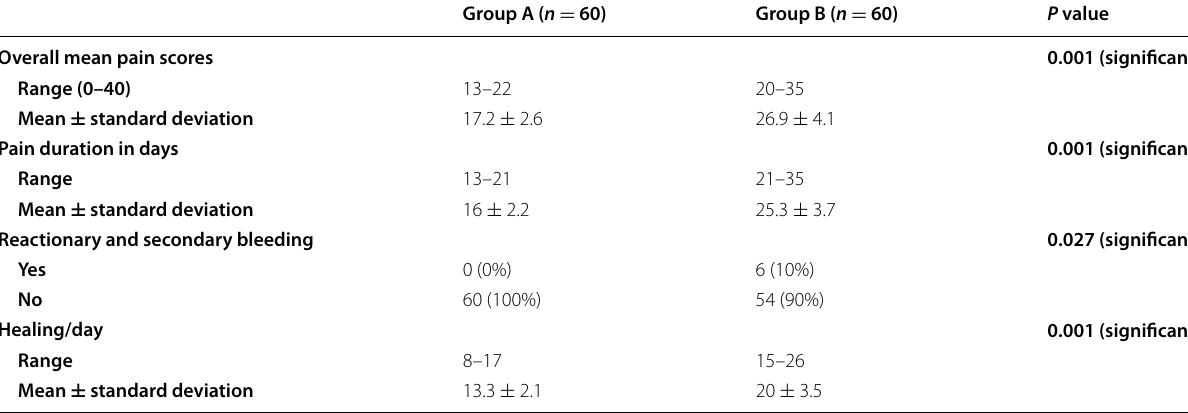
Table 3 Comparison between both groups for different study